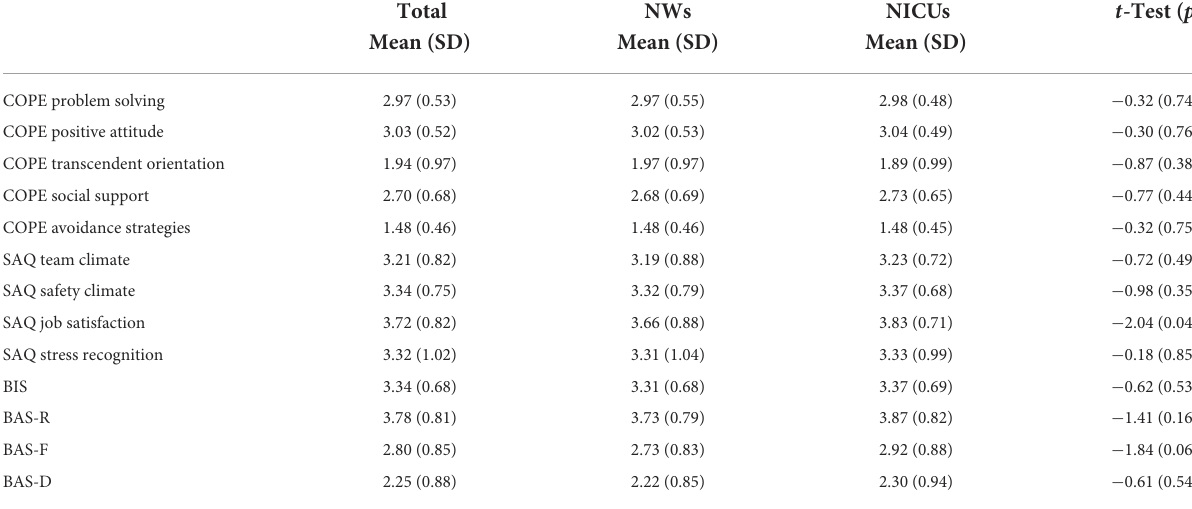
TABLE 3 Descriptive statistics (raw values) and t -test results comparing professionals from neonatal wards (NWs) and neonatal intensive care units (NICUs) on study